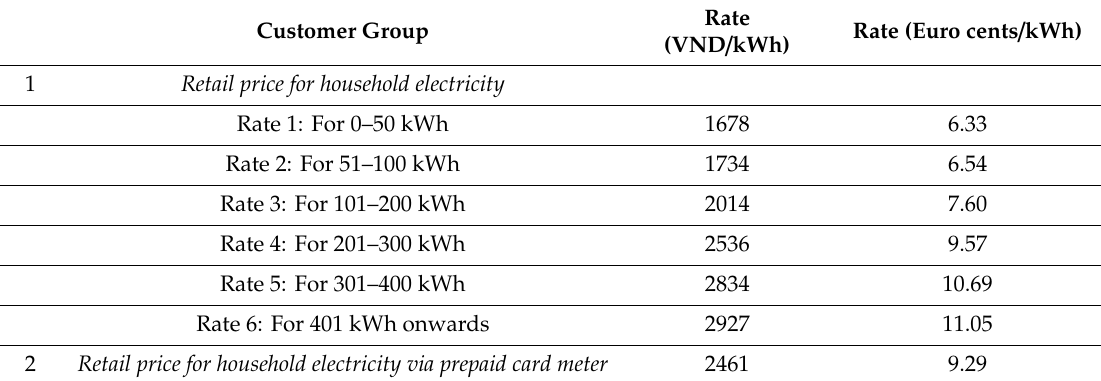
Table A1. Retail electricity tari ff for household customers (published 20 / 03 / 2019). Customer